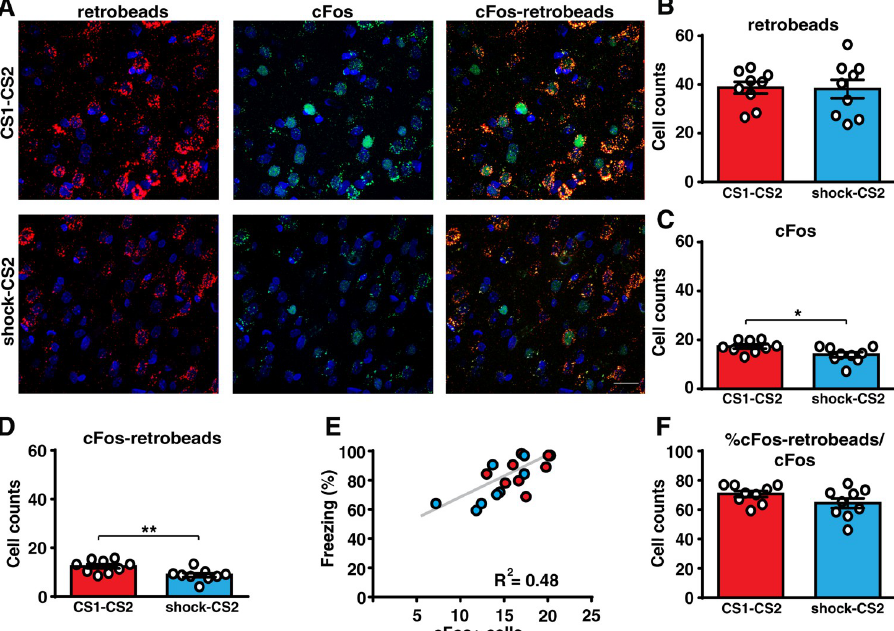
Fig 2. Prior auditory fear learning increases the activity in the Te2-to-BLA pathway. (A and B) The number of neurons within layer 2/3 of the Te2 projecting to the BLA (retrobeads-labeled) was similar between animals that were trained in two different CS-US associations (CS1-CS2, n = 9, upper panel) and in those who received only painful stimuli followed by the CS2-US association 2 weeks later (shock-CS2, n = 9, lower panel) (Student t test, t (16) = 0.11, p = 0.9132, Glass’s delta = 0.006). Scale bars, 20 μ m. (C) After retention of the recent fear memory, the expression of cFos protein was higher in the CS1-CS2 group (Student t test, t (16) = 2.49, p = 0.0238, Cohen’s d = 0.117). (D) Importantly, the number of cells that project from the Te2 to the BLA and that colocalized with cFos expression was higher in this group (Student t test, t (16) = 3.05, p = 0.0076, Cohen’s d = 2.99). (E) Freezing of CS1-CS2 and shock-CS2 rats to the recent CS correlated with the number of cFos positive cells in Te2 (Pearson’s correlation, r = 0.69, p = 0.0013). (F) The percentage of double-positive cells on the total cFos positive cells was similar between the 2 groups (Student t test, t (16) = 1.59, p = 0.1302, Glass’s delta = 0.627). � P < 0.05, �� P < 0.01. All data are mean and SEM. The summary data for Fig 2 can be found in Supporting information in the file named S2 Data. BLA, basolateral amygdala; CS, conditioned stimuli; US, unconditioned